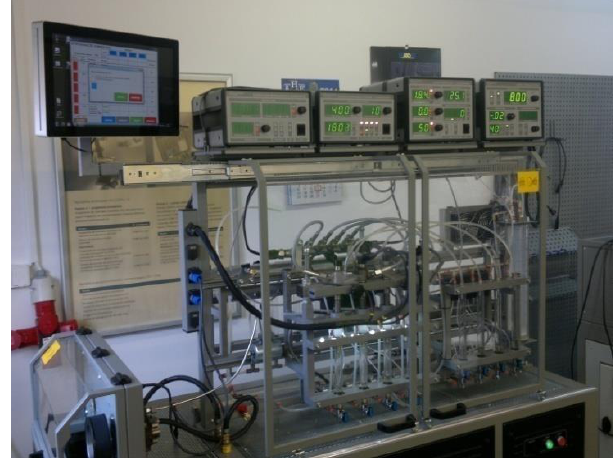
Fig. 2. Test bench STPiW-3 [17]